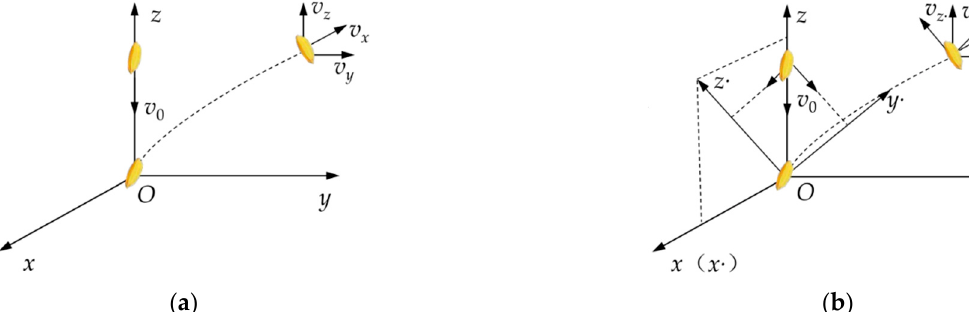
Figure 4. Kinematics analysis of rice grain in collision process: ( a ) simplified model of collision with horizontal collision platform; ( b ) simplified model of collision with inclined collision platform.